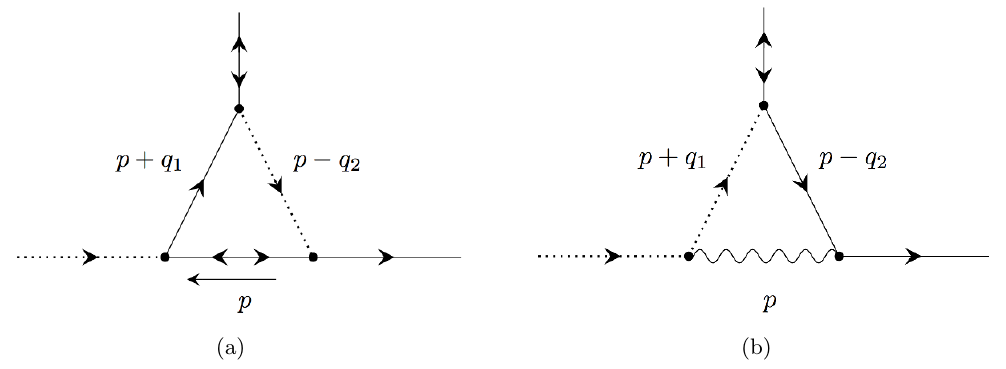
Figure 8 . The Yukawa coupling renormalization in the N = 1